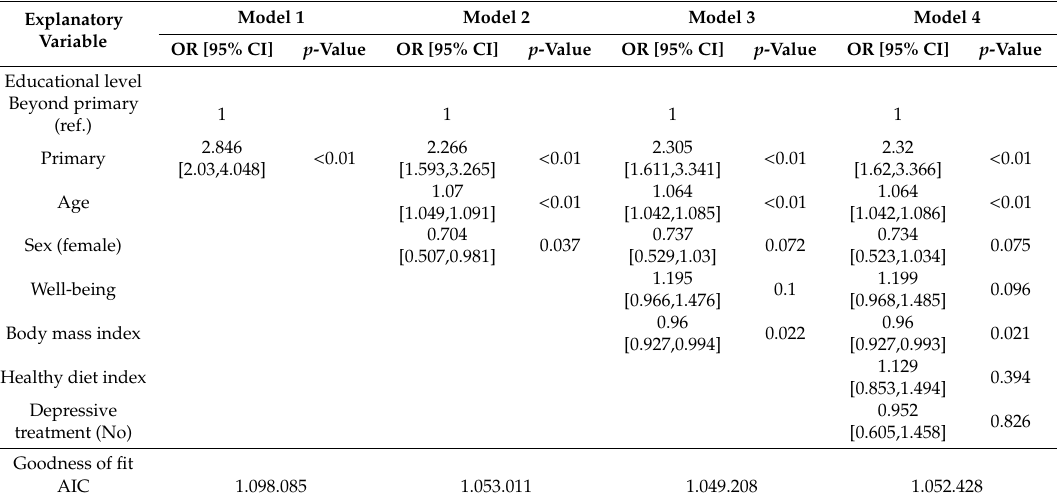
Table 2. The odds ratio for cognitive impairment according to di ff erent models.